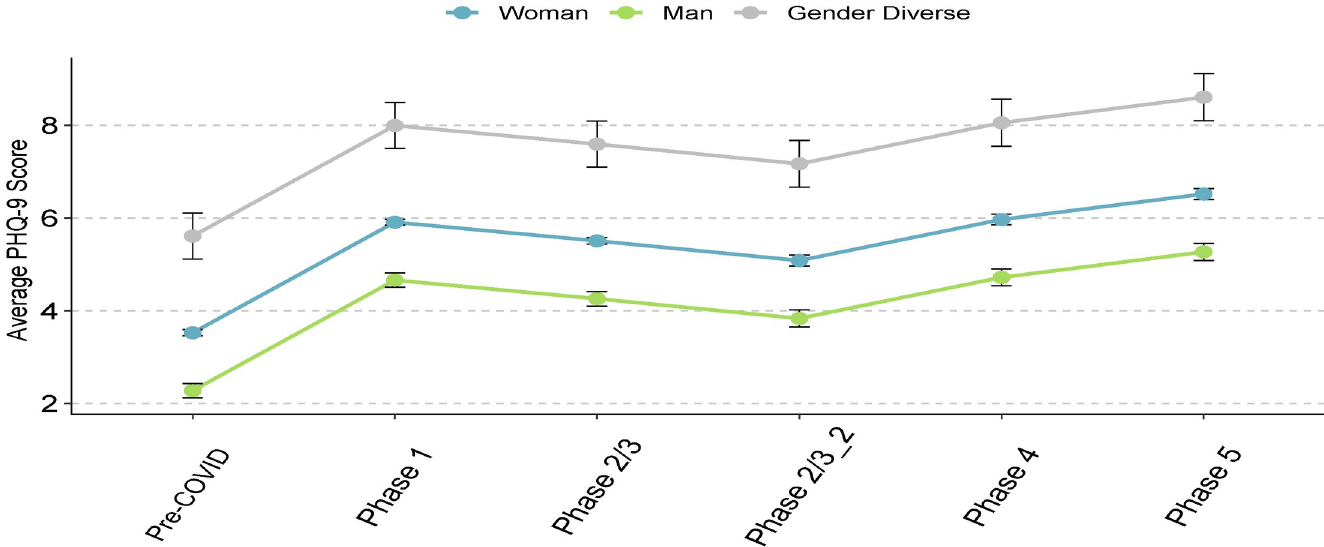
Fig 2. Depressive symptoms, as measured by the PHQ-9, across phases of the pandemic. Data points refer to mean scores of the given psychosocial measure, error bars refer to the standard error. Pre-COVID: Prior to mid-March 2020; Phase 1: Mid-March 2020 to mid-May 2020; Phase: 2/3: Mid-May 2020 to November 2020;